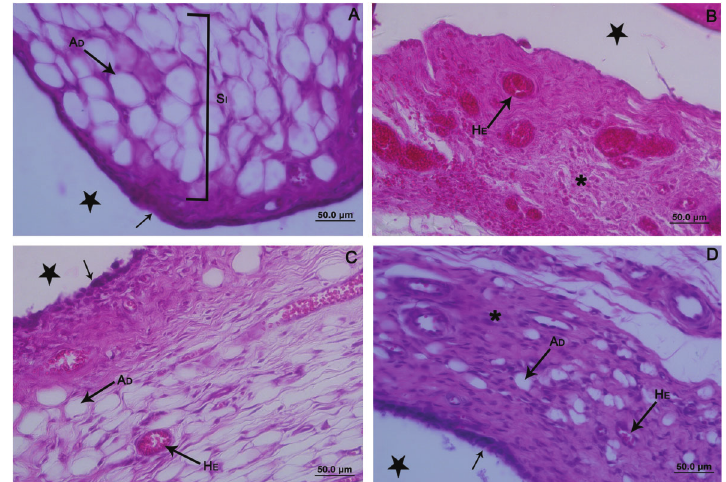
Figure 3. Photomicrographs of the synovial mem- brane of the ankle joint of Wistar rats. Sagittal section, hematoxylin and eosin staining. A : Control contralateral hindlimb.Membranewith thinsynovial intima (black arrow), and subintima (SI) with predo- minance of fat cells (AD). B , G1 group, thickening of the synovial membrane, which was predomi- nantly fibrous (asterisk) and with blood vessels (HE) full of red blood cells that spilled over the connective tissue. C , G2 group, synovial mem- branewiththickeningintheapicalregionandintima with disorganized synoviocytes (black arrow). Presence of adipocytes (AD) in the subintima, with a moderate amount of red blood cells within the blood vessels (HE). D , G3 group, synovial mem- brane with areas of reorganization of the intima (black arrow). Subintima less fibrous (asterisk), with fat cells (AD) and few red blood cells in the blood vessels (HE). Articular cavity (star). G1: immobilized; G2: remobilized freely for 14 days; G3: remobilized by swimming and jumping in water for 14